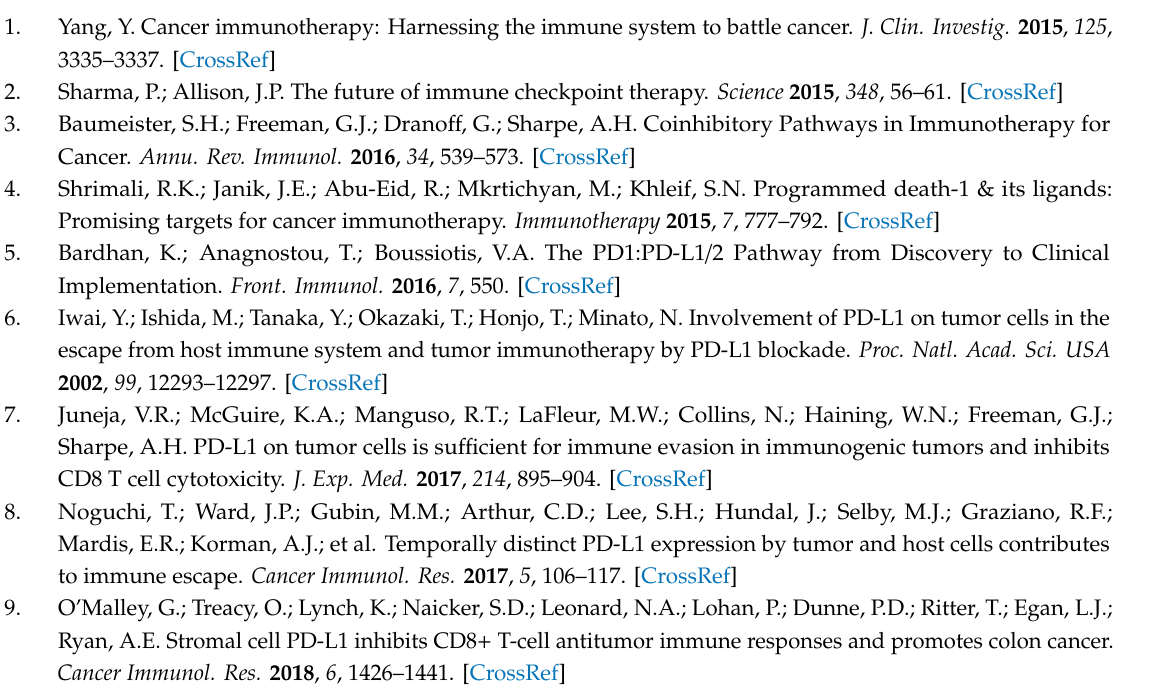
Figure S1: Quality assessment of recombinant mPD-1, HEK-293T / mPD-1 + cells and recombinant endotoxin-free Nbs; Figure S2: Immunofluorescence staining of BHK and HuH-7 cells transfected with AAV-Nb11 plasmids; Figure S3: Evaluation of toxicity of AAV-CAG-Nb11 treatment in